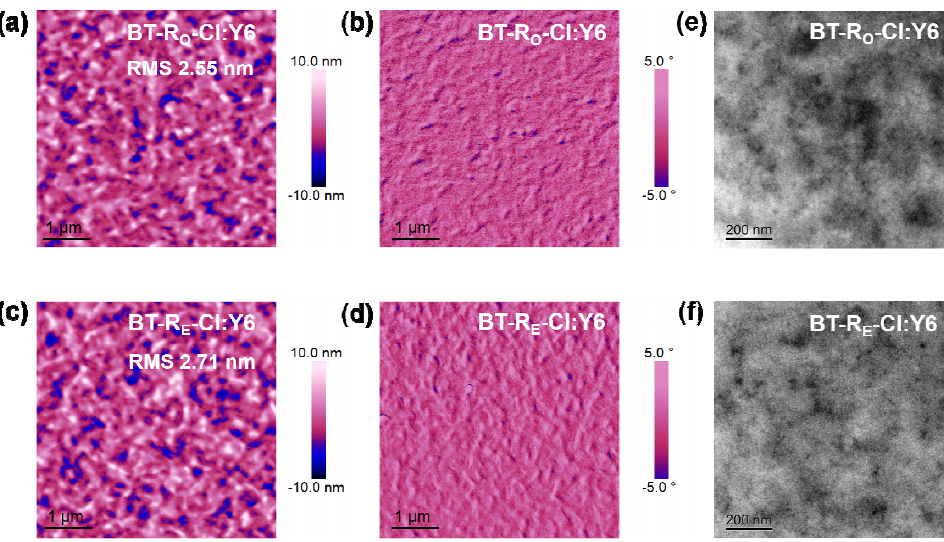
Figure 5. The surface morphology of BT-R O -Cl:Y6 and BT-R EH -Cl:Y6 blended films: ( a – d ) AFM and ( e , f ) TEM images.